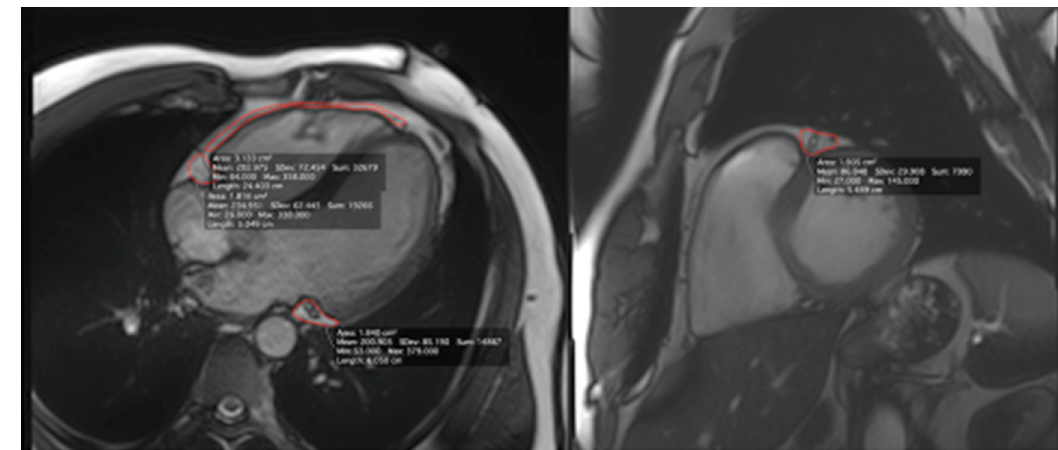
Figure 1. Example of pericoronary adipose tissue calculation with cardiac magnetic resonance by measurement of the area around the main coronary arteries and over the free wall of the right ventricle (epicardial adipose tissue).